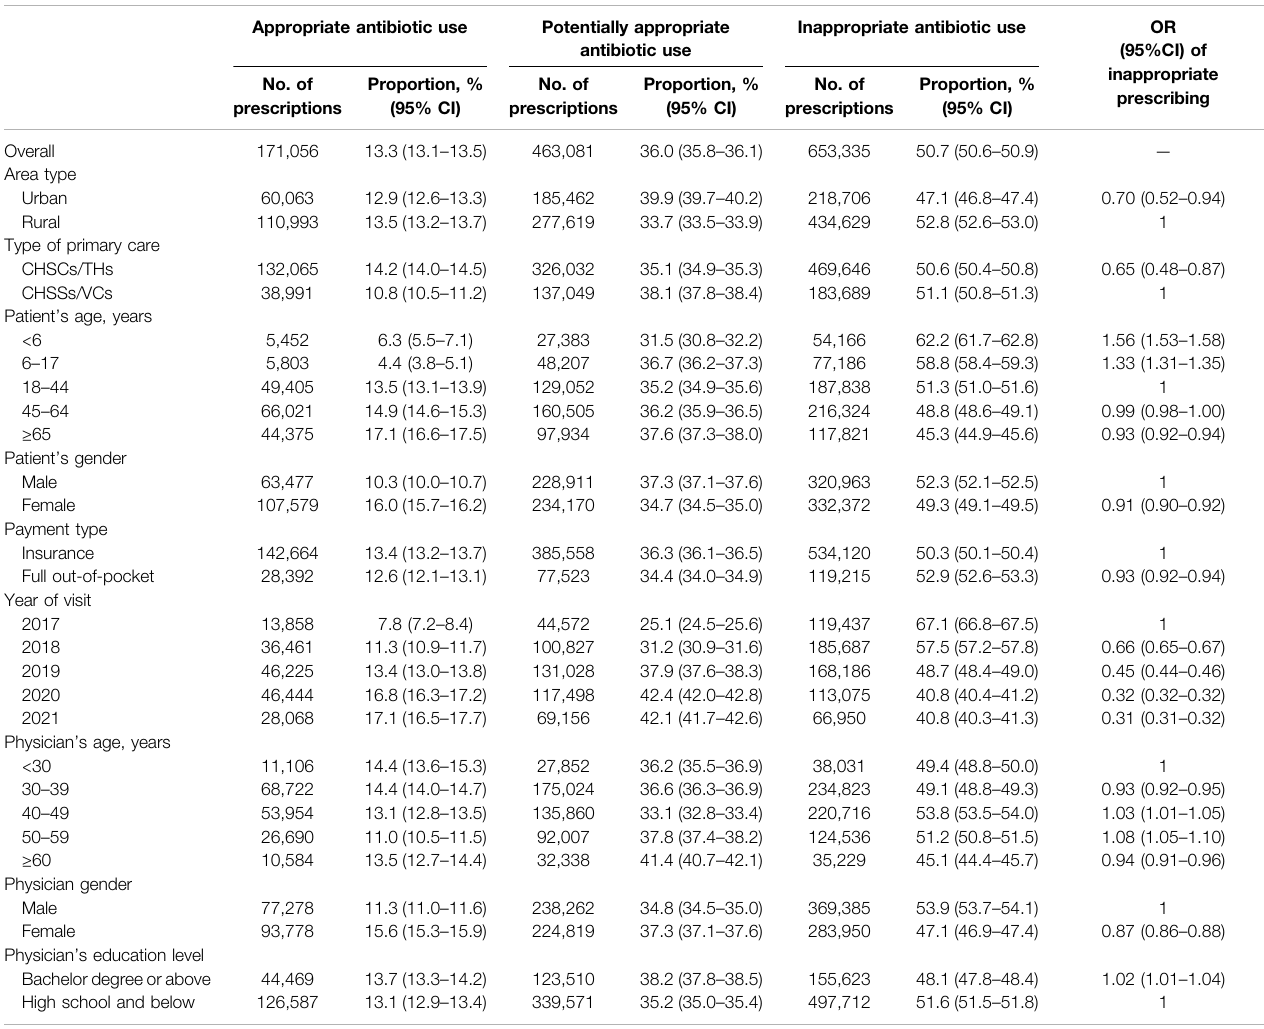
TABLE 2 | Proportion of antibiotic prescriptions in each appropriateness category for various subgroups.